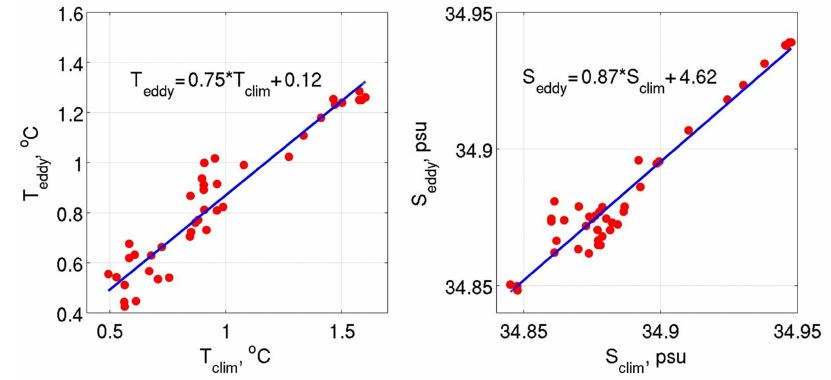
Figure 9. Mean temperature / salinity ( T eddy /S eddy ) inside the eddy core versus climatological temperature / salinity ( T clim /S clim ) at the eddy origin. Each temperature / salinity was averaged within the water layer spanned by the eddy.